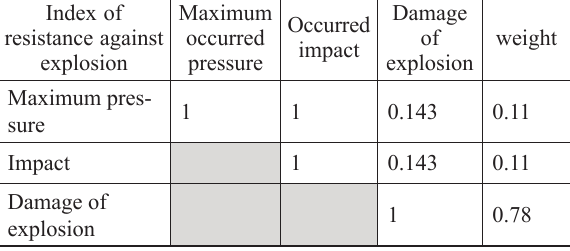
Table 4. Importance degree of assessment indexes and selection of index of resistance against explosion Index of resistance against explosion